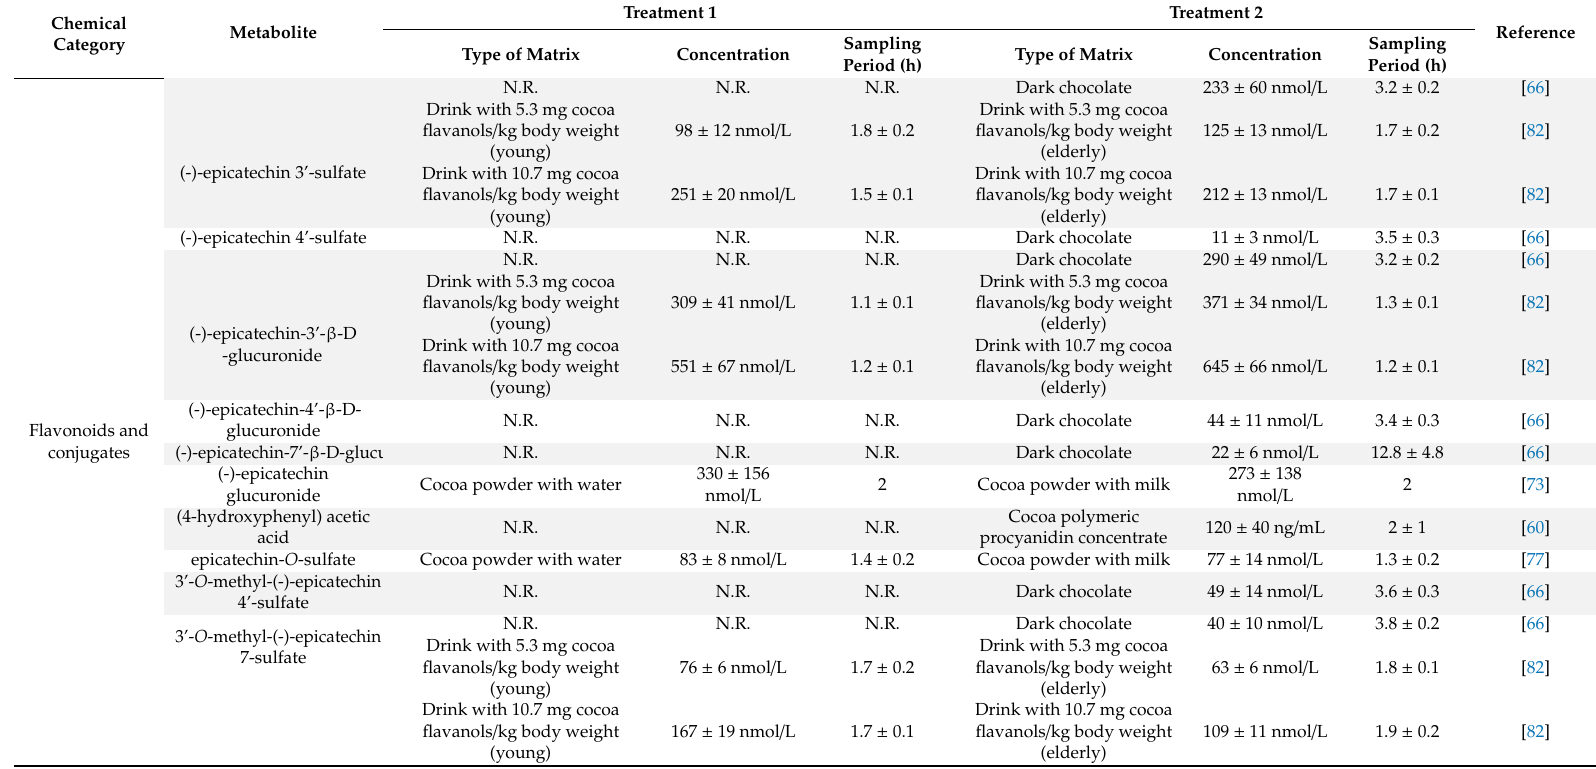
Table 4. Metabolites analyzed in plasma after di ff erent acute cocoa intake interventions, by targeted